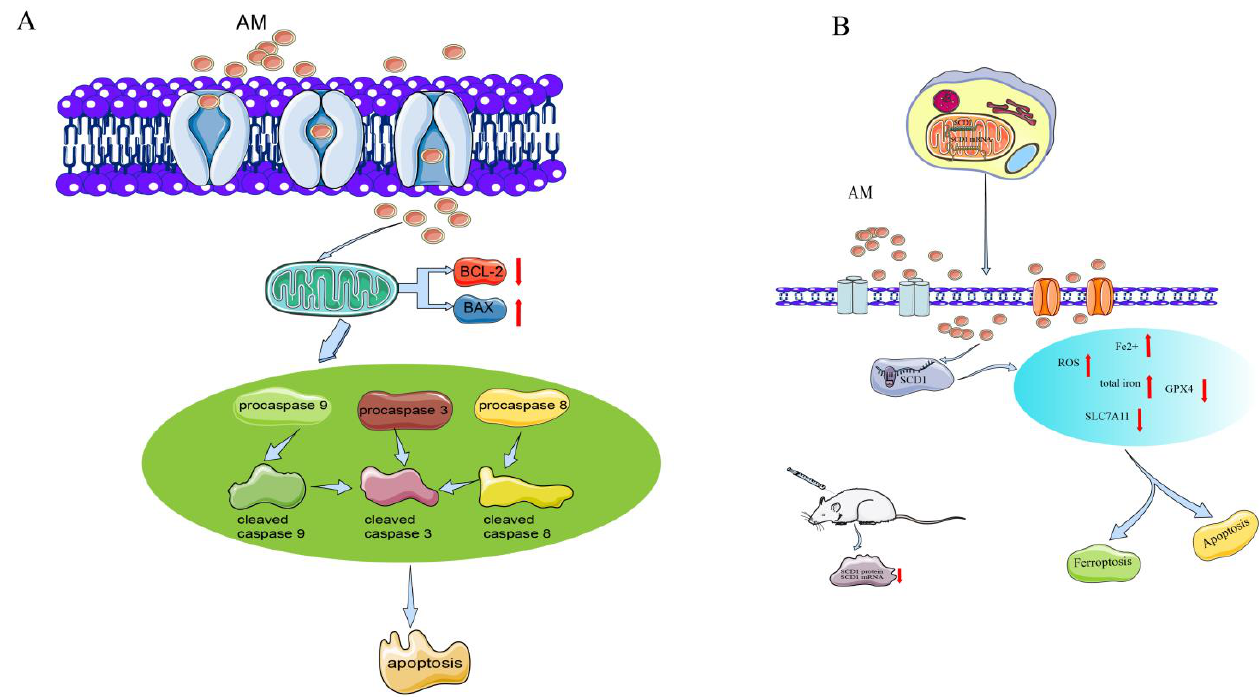
Figure 3. Mechanism of AM for its antitumor effects. ( A ) Anti-gastric cancer; and ( B ) anti-ovarian cancer.